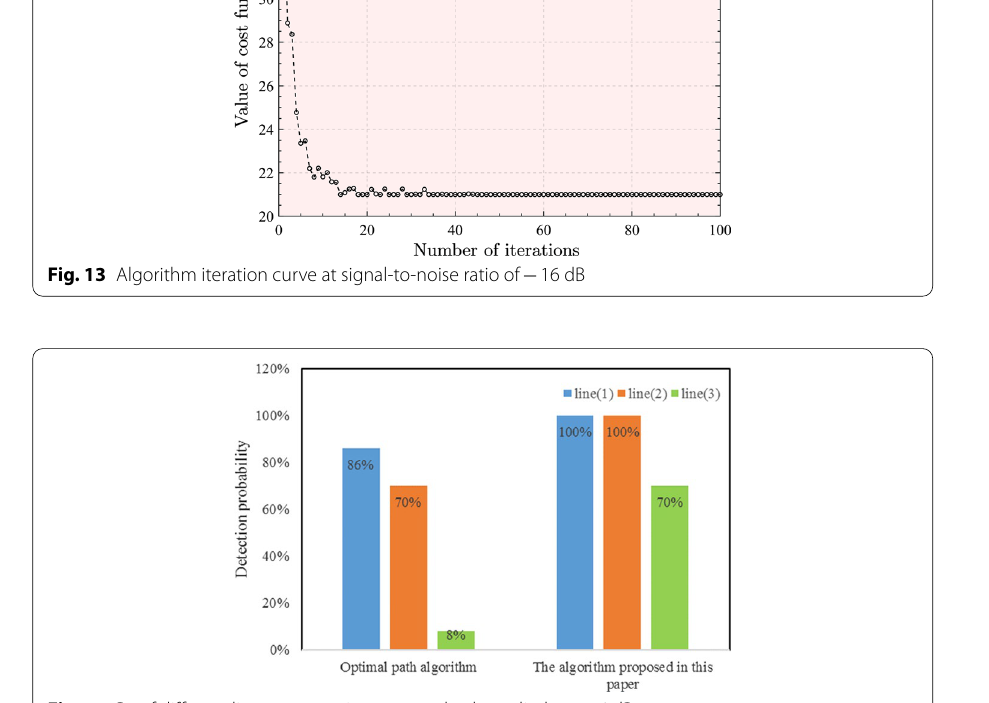
Fig. 14 P D of different line spectra using two methods studied at